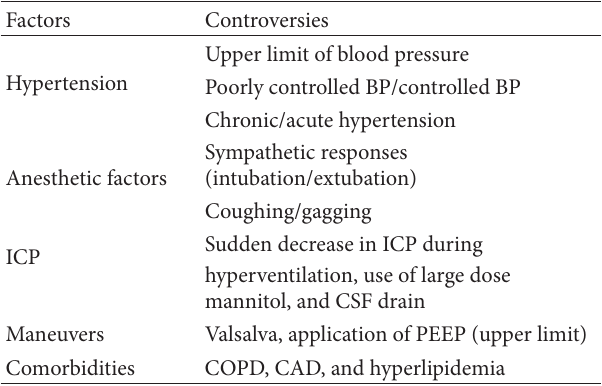
Table 1: Intraoperative factors contributing to intraoperative aneurysm